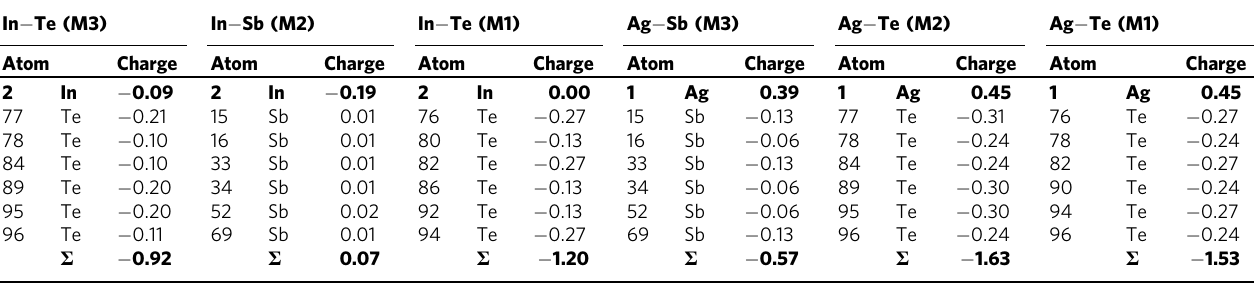
Table 1 Mulliken charge analysis of the In and Ag-substituents in models M1 – M3 as generated by LOBSTER In − Te